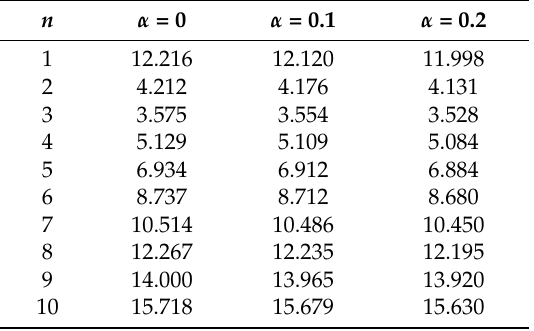
Table 6. Variation of the natural frequency ω (GHz) against the circumferential wave number n for different porosity volume fractions α of FGPM-I nanoshell